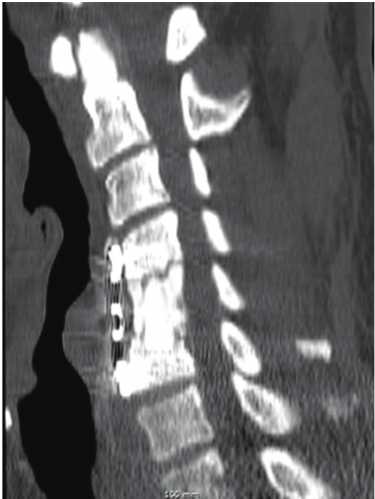
F 5: Sagittal CT reconstruction at the latest followup shows gra consolidation con�rming fusion.